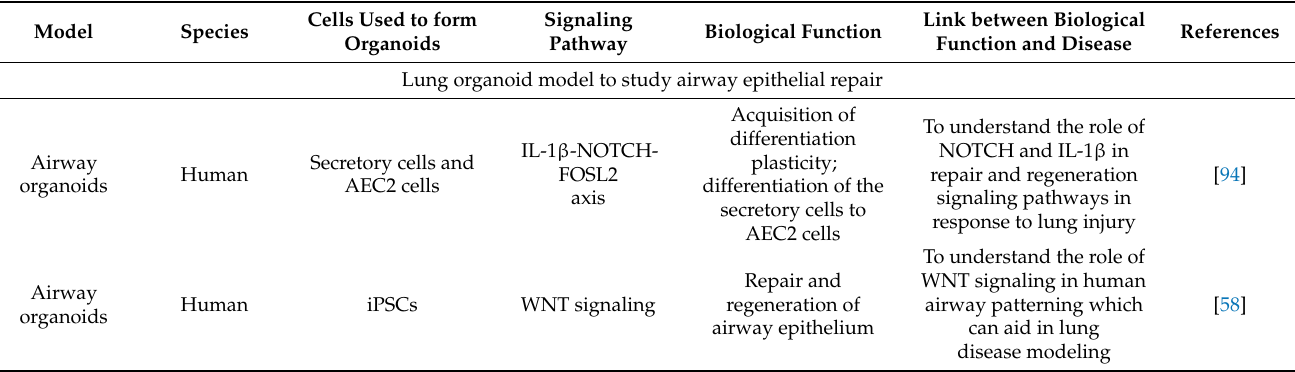
Table 2. Molecular pathways and functions in organoid models during epithelial